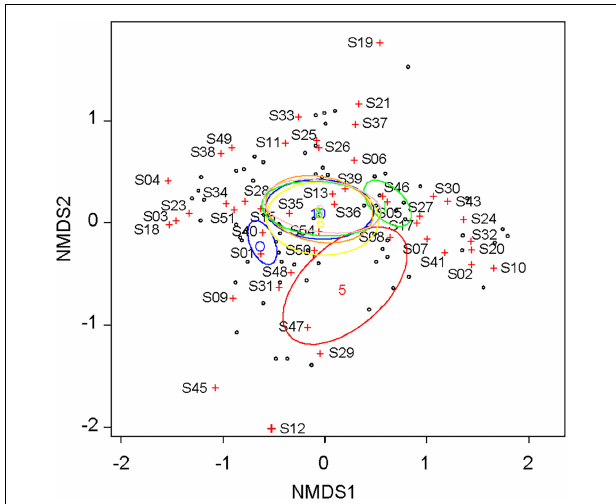
assemblages. Ellipses for the 95% confidence interval of the centroid were shown for inside and outside of the fence and for each month from May to October. See Supplementary Table S1 for taxa